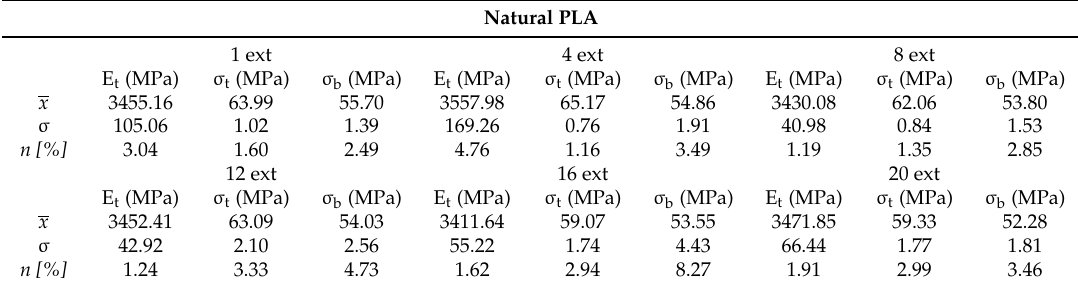
Figure 2. Graphical Representation of the ( a ) Tensile Modulus (E t ); ( b ) Tensile Strength ( σ t ) and ( c ) Stress at break ( σ b ) of the three formulations by each extrusion.